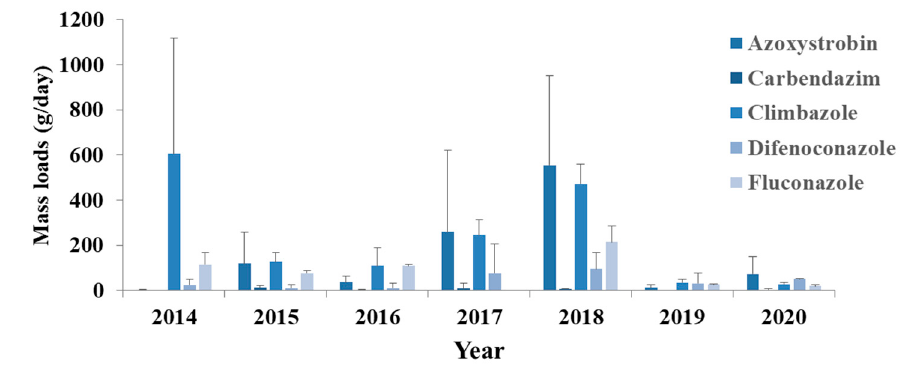
Figure 2. Mass loads of the most frequently detected fungicides (azoxystrobin, carbendazim, climbazole, difenoconazole and fluconazole) in influent wastewater collected in Athens.